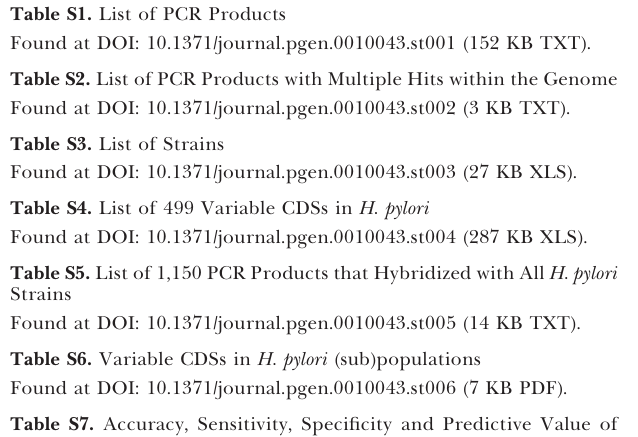
Figure S3. CDSs Present or Absent within 24 Small Regions of 56 H. pylori and Four H. acinonychis Strains These regions are scattered along the chromosome, contain two to nine CDSs and contain CDSs that are uniformly lacking in at least one population. Red, absent; yellow, present; black, missing data. Figure S4. Size Distribution of Variably or Universally Present CDSs within H. pylori and H. acinonychis Figure S5. Bioinformatic Predictions of Hybridization based on FASTA Analyses of the Genomic Sequences of hpAfrica2 Strain 162.0 and H. acinonychis strain Sheeba